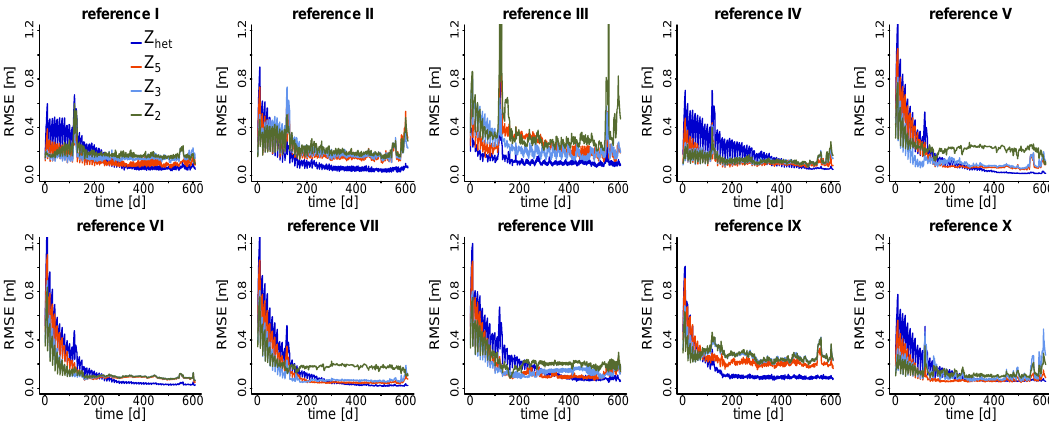
Fig. 6. RMSE h of conditional simulations with EnKF for ten reference fields of leakage coefficients (scenario A). Four different ensembles are compared. EnKF jointly updated hydraulics heads and leakage coefficients with 100 piezometric head data.